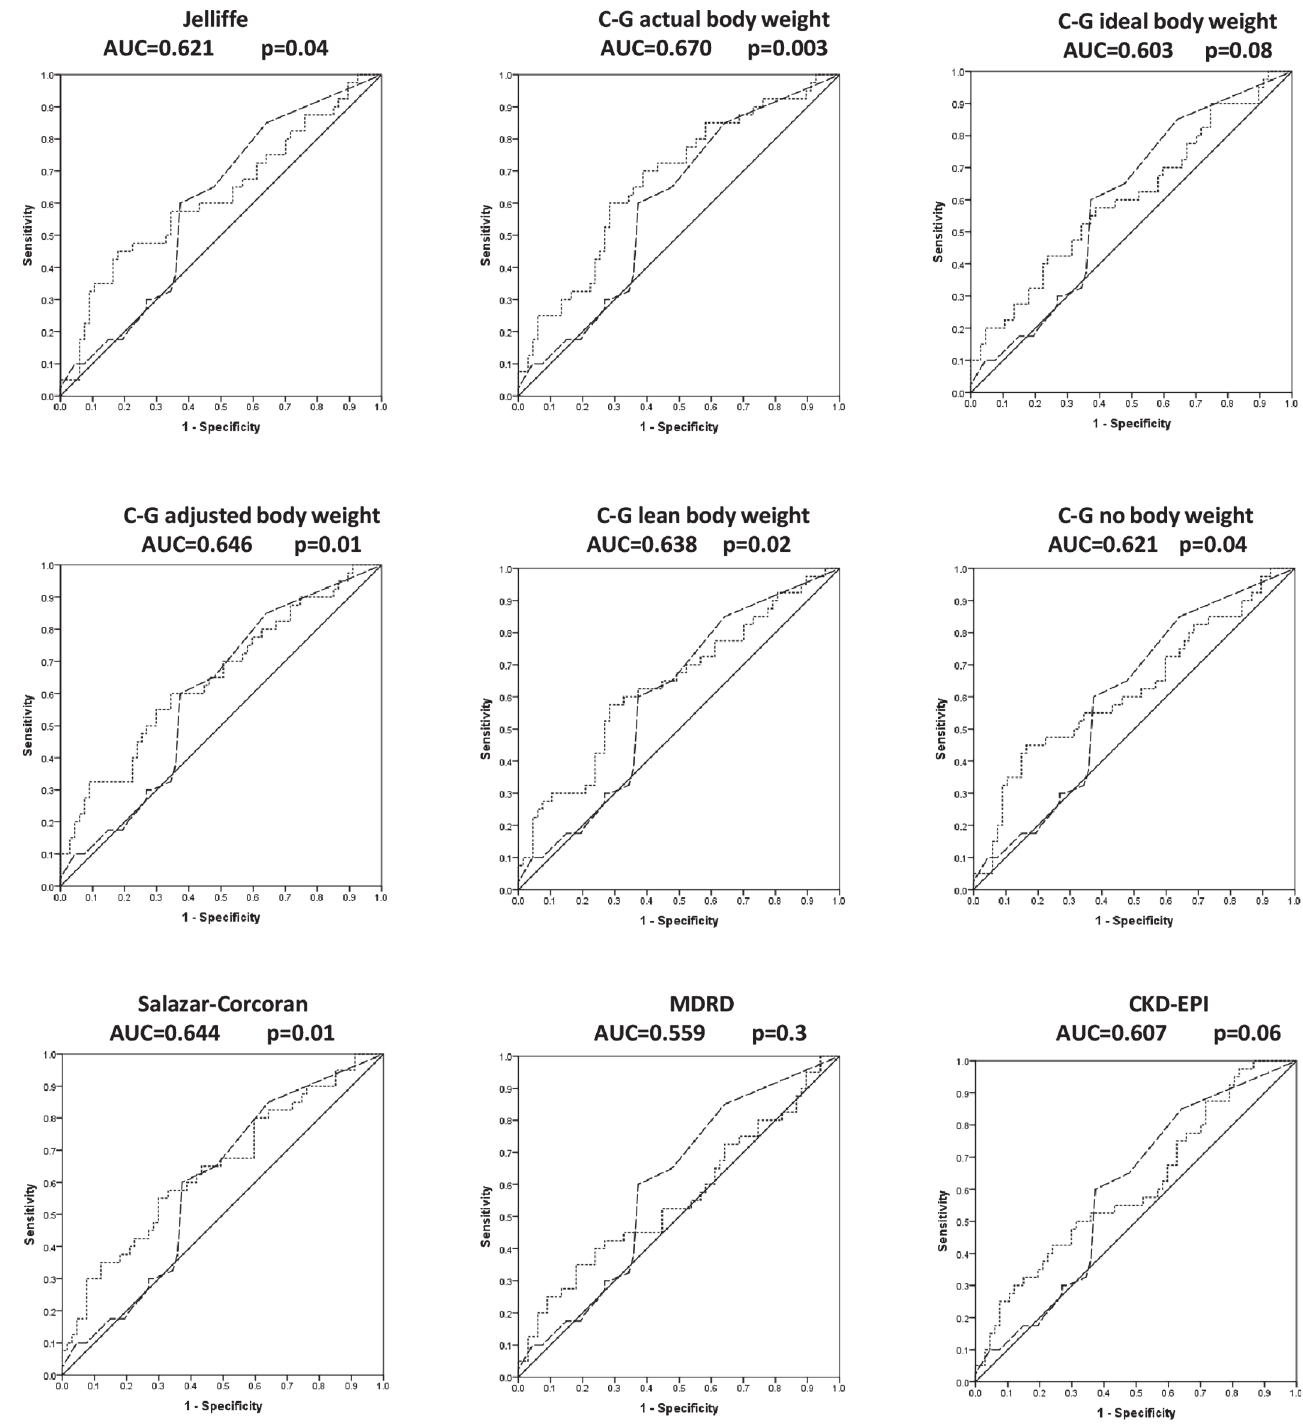
Fig 1. Receiver operator characteristic curves showing the accuracy of the eGFR equations (AUCs shown as dotted lines) in predicting plaque presence independent of the mFramingham score (AUCs shown as dashed lines). The P values given are for the AUC-plaque associations. The mFramingham score was consistently unrelated to plaque presence (AUC = 0.596 ( P = 0.1) in each analysis). EGFR = estimated glomerular filtration rate; AUC = area under the curve; C-G = Cockcroft-Gault; MDRD = Modification of Diet in Renal Disease; CKD-EPI = Chronic Kidney Disease Epidemiology Collaboration.